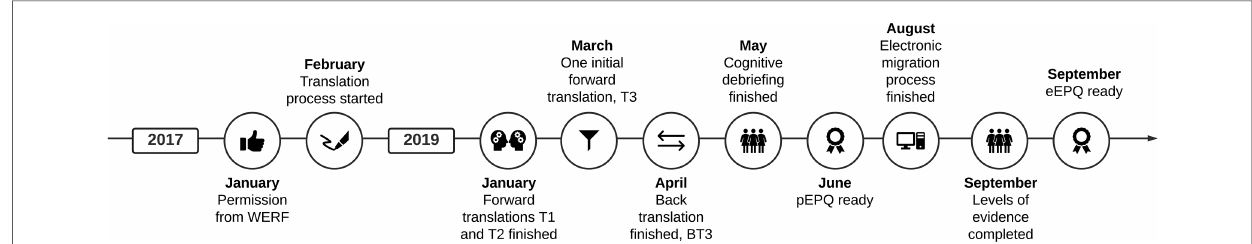
FIGURE 3 Timeline for developing the Danish paper and electronic EPQ.eEPQ, Danish electronic versionofthe Endometriosis Patient Questionnaire; EPQ, Endometriosis Patient Questionnaire; pEPQ, Danish paper version of the Endometriosis Patient Questionnaire; WERF, World Endometriosis Research Foundation. Created in Lucidchart (www.lucidchart.com).